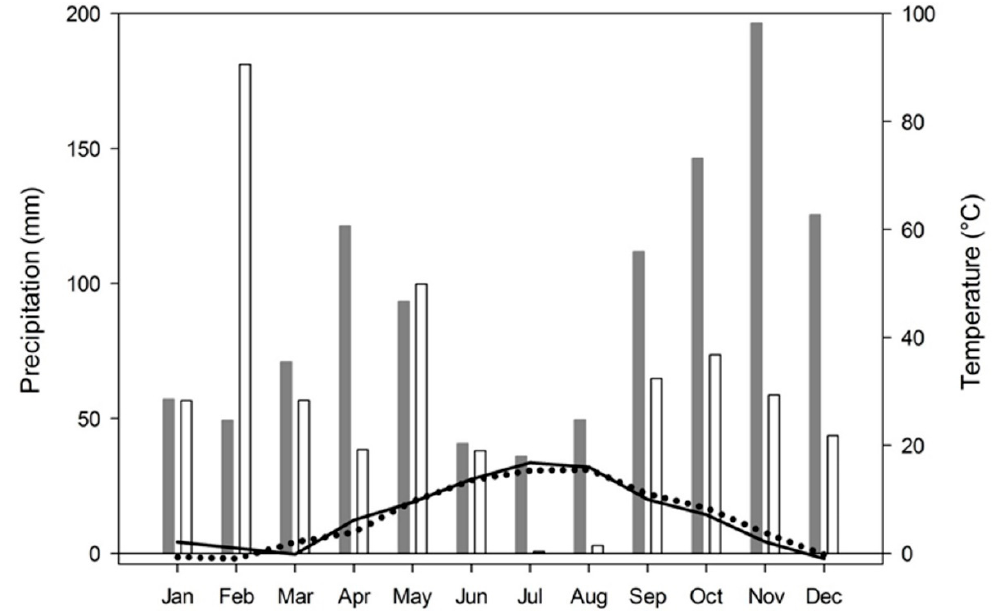
Figure 2. Climatic diagram of the Selva Piana stand. White bars represent the monthly sums of precipitation in 2007; grey bars represent mean monthly precipitation for 1996–2006; black and dotted lines represent the mean monthly temperatures in 2007 and for the period 1996–2006, respectively.